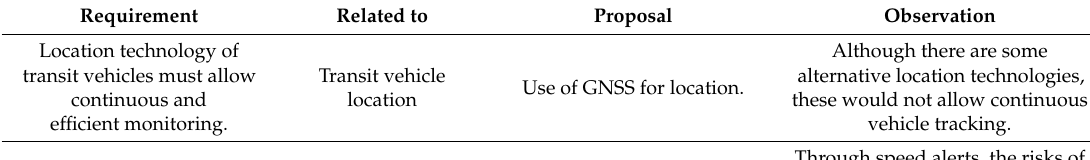
Table 3. Requirements determined for the